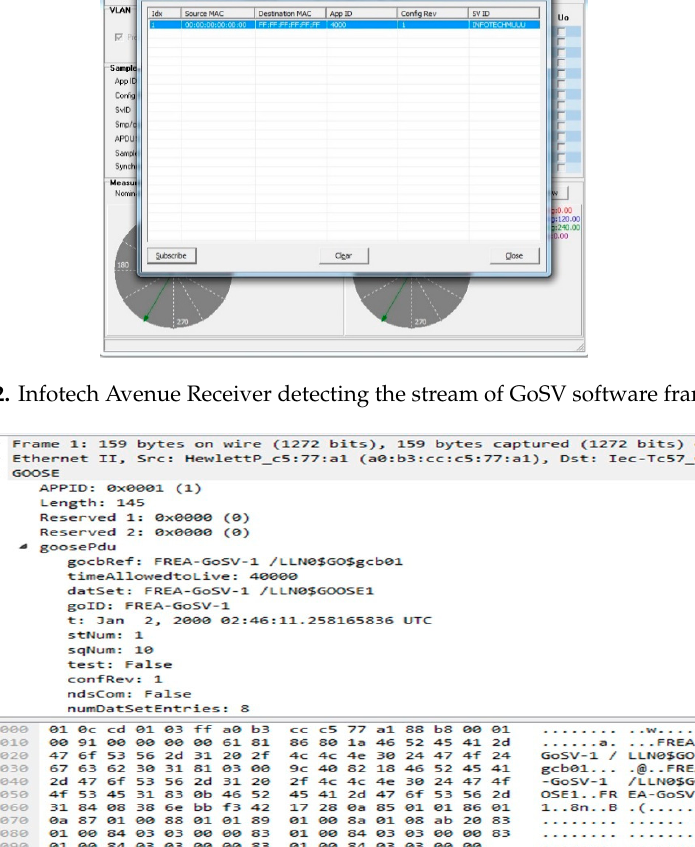
10 of 14 Figure 10. GoSV software program sending custom GOOSE frames.